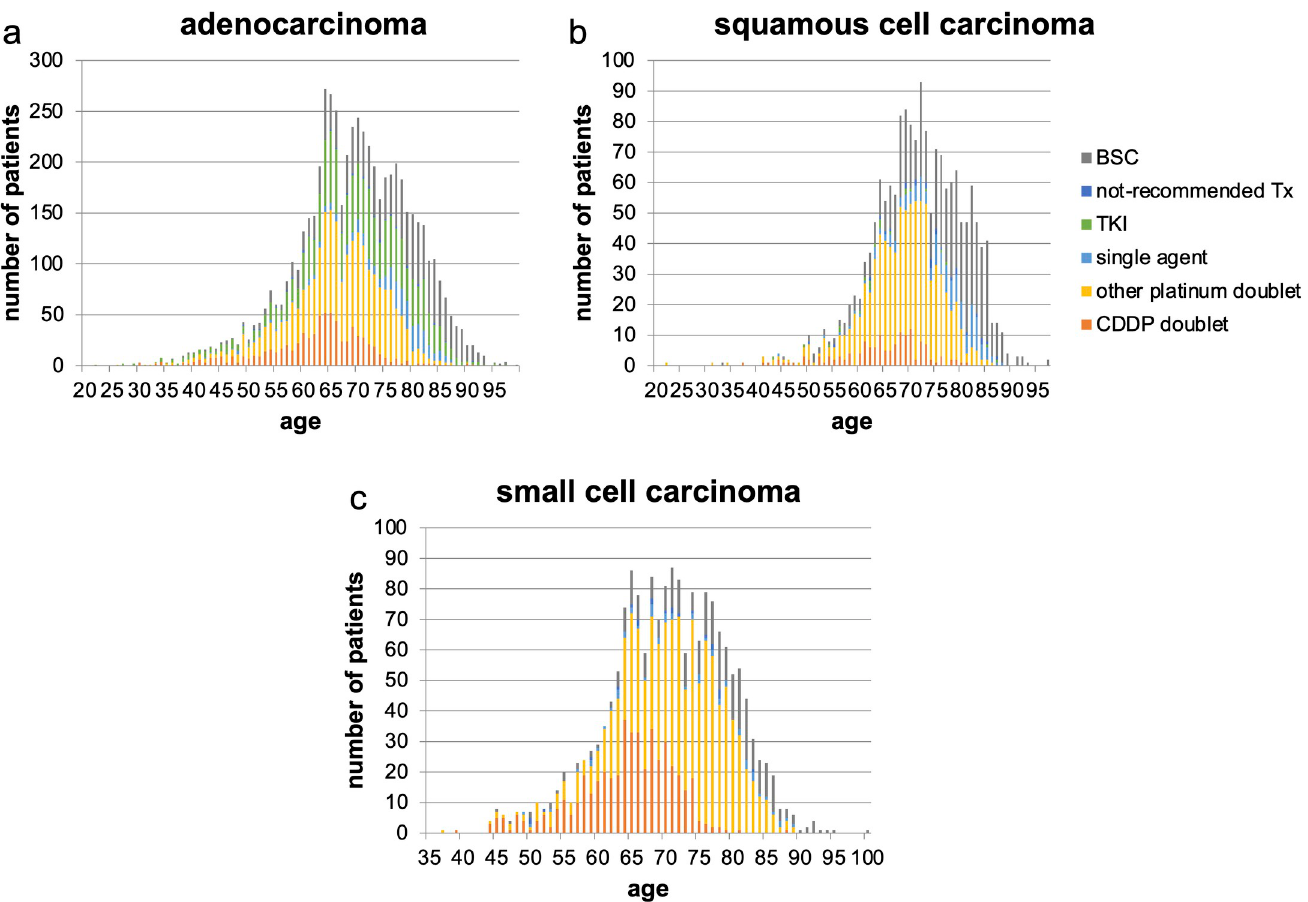
Fig 3. First-line treatment choice by histology. (a) adenocarcinoma, (b) squamous cell carcinoma, and (c) small cell carcinoma. CDDP, cisplatin; TKI, tyrosine kinase inhibitor; not-recommended Tx, not-recommended chemotherapy; BSC, best supportive care.